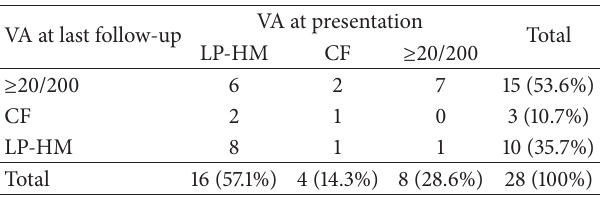
Table 5: The distribution of initial and final visual acuity for eyes with nontraumatic vitreous